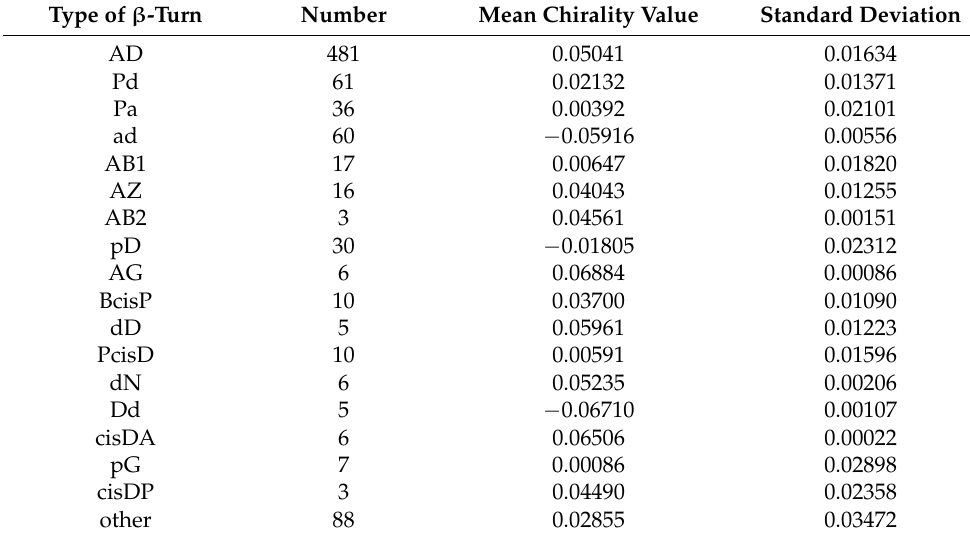
Table 2. Mean values and standard deviations of chirality for β -turns of various types (according to [89]), calculated using the method for evaluating the chirality of regular helical and irregular protein secondary structures. The proteins with β -turns are